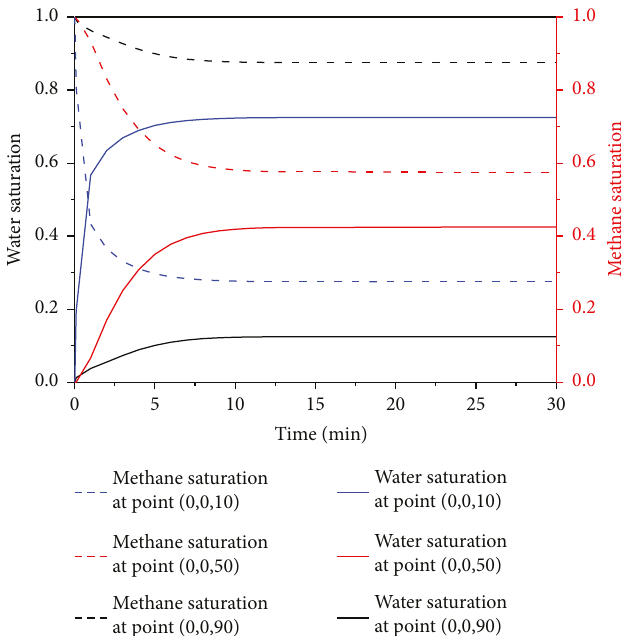
Figure 10: Space-time distribution curve of the water-methane two-phase saturation at the axial monitoring points along the driving